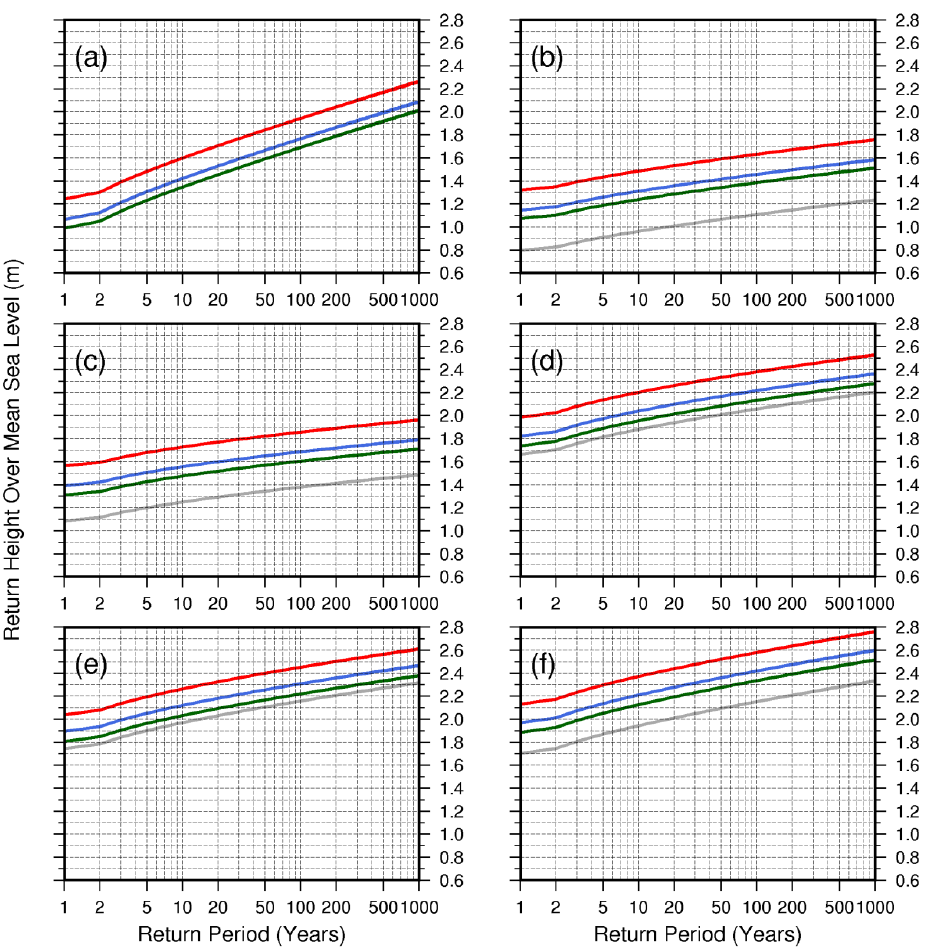
Figure 12. Return heights for stationary sea level (grey) and for ensemble mean RSL projections over the period 1986–2005 to 2081–2100 for RCP2.6 (green), RCP4.5 (blue) and RCP8.5 (red) at the six key locations: ( a ) Oslo; ( b ) Stavanger; ( c ) Bergen; ( d ) Heimsjø; ( e ) Tromsø; and ( f ) Honningsvåg. Note that the grey and blue lines coincide for Oslo.